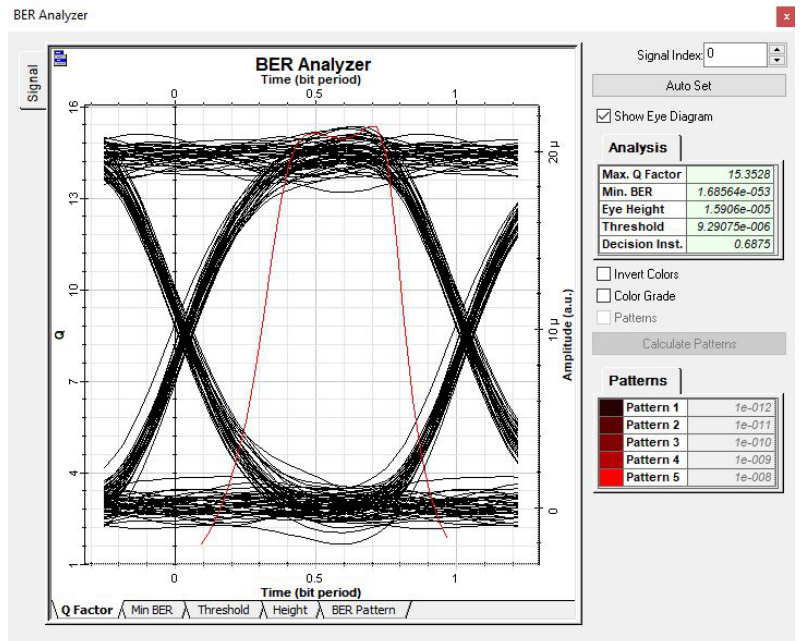
Figure A1. Receiver 1 eye pattern for 40 km